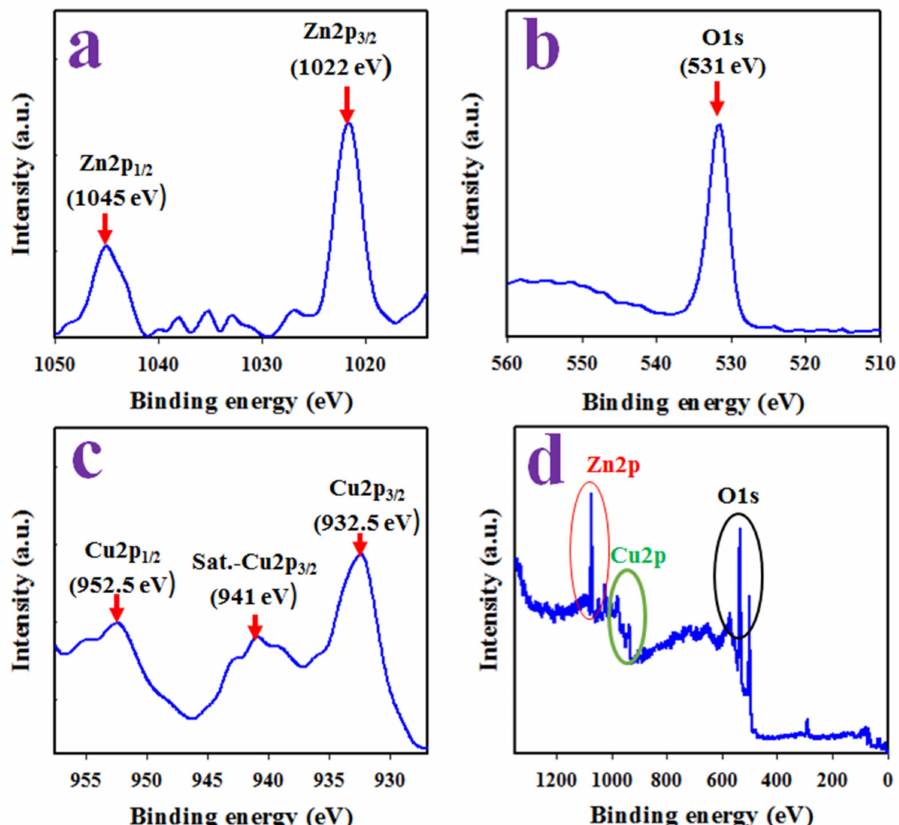
Figure 4. ( a ) The spin orbitals of Zn2p level. ( b ) XPS spectra of O1s level. ( c ) Cu2p spin orbital. ( d ) Full XPS spectrum of prepared CuO/ZnO